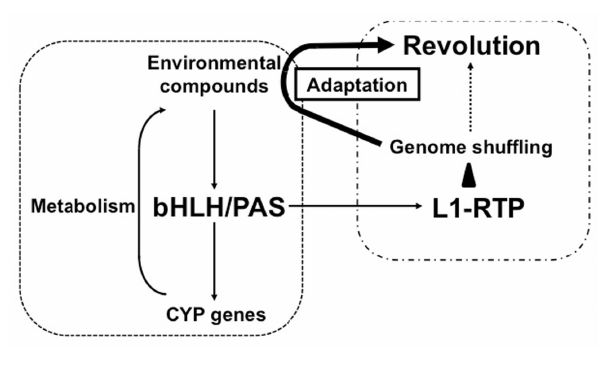
FIGURE 2 | Possible functional link between bHLH/PAS proteins and L1-RTP in environmental adaptation and evolution. As a well-characterized biological function, bHLH/PAS proteins of AhR and ARNT1 induce gene expression of CYP genes in response to various compounds.The induced CYP proteins metabolize the environmental compounds and detoxify them. By contrast, L1-RTP induces genome shuffling, and random mutagenesis increases the chance of the emergence of living organisms that possess novel characteristics. As shown here, bHLH/PAS proteins are involved in the induction of L1-RTP, indicating the functional link between these two well-conserved cellular activities.The novel properties can overcome the disadvantageous effects of environmental compounds, enabling living organisms to survive under the selective pressure in the altered environment and contributing to